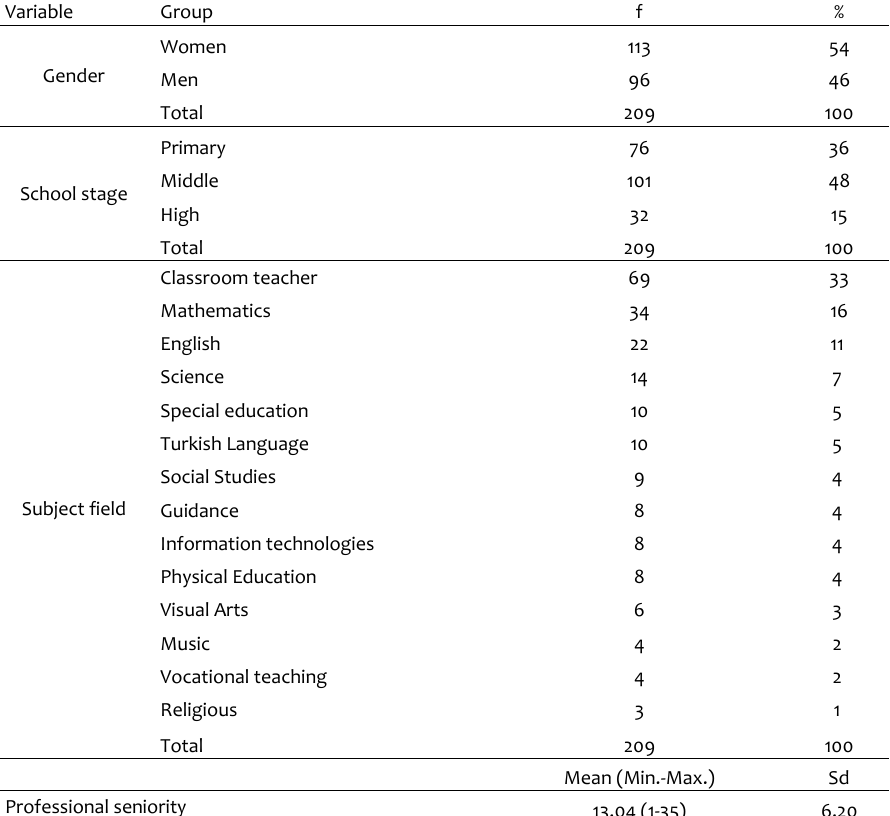
Table 1. Information about participating teachers (N =